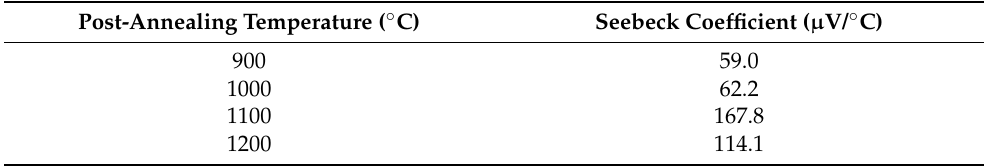
Figure 6. Thermoelectric voltages of 0.2LSCO-Pt TFTCs at different temperature differences. Table 2. Average Seebeck coefficients of 0.2LSCO thin films at different post-annealing tempera- tures.